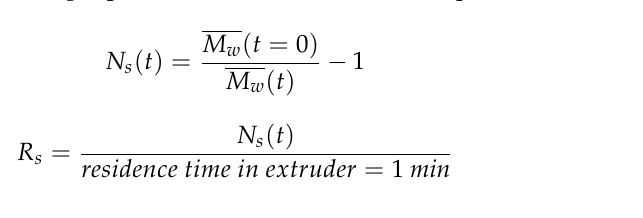
Table 3. Molecular weight values of PHBV before and after extrusion and PHBV/ground paunch composites after extrusion at fibre contents from 10 to 50 wt%, at increments of 10 wt%. ¯ M n